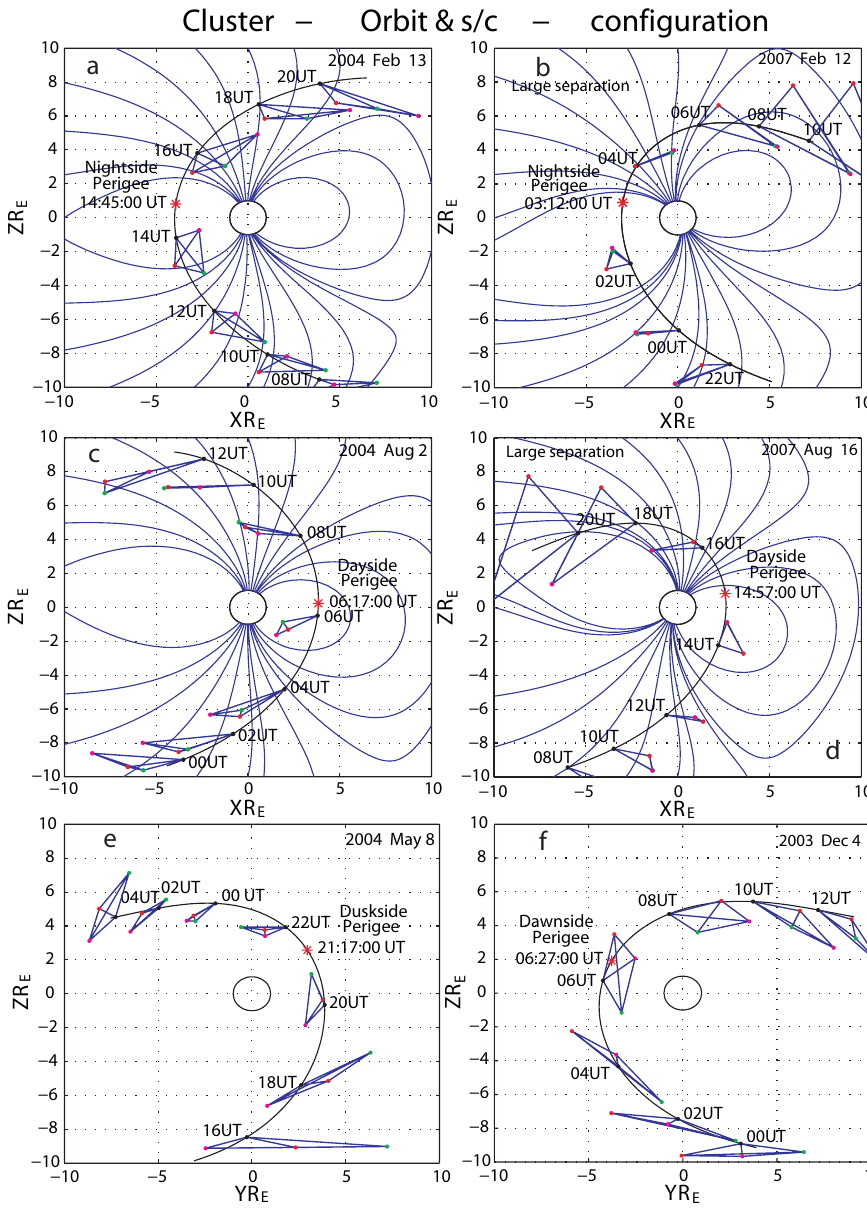
Fig. 1. Orbit plots in XZ or YZ plane in GSM coordinates for night-side orientations orbit 558/559 on 13 February 2004 (a) and 1018/1019 on 12 February 2007 (b) , for dayside orientations orbit 630/631 on 2 August 2004 (c) and 1096/1097 on 16 August 2007 (d) , and for dusk- dawn orientation orbit 594/595 on 8 May 2004 ( e , duskside) and 528/529 on 4 December 2003 ( f , dawnside), respectively. The orbit also shows the configuration of the Cluster spacecraft array as a tetrahedron (size scaled up by a factor of 80 for Fig. 1a and f, 5 for Fig. 1b and d, and 20 for Fig. 1c and e). Model geomagnetic field lines are drawn from the T01 model with the average inputting parameters during the interval of interest on each